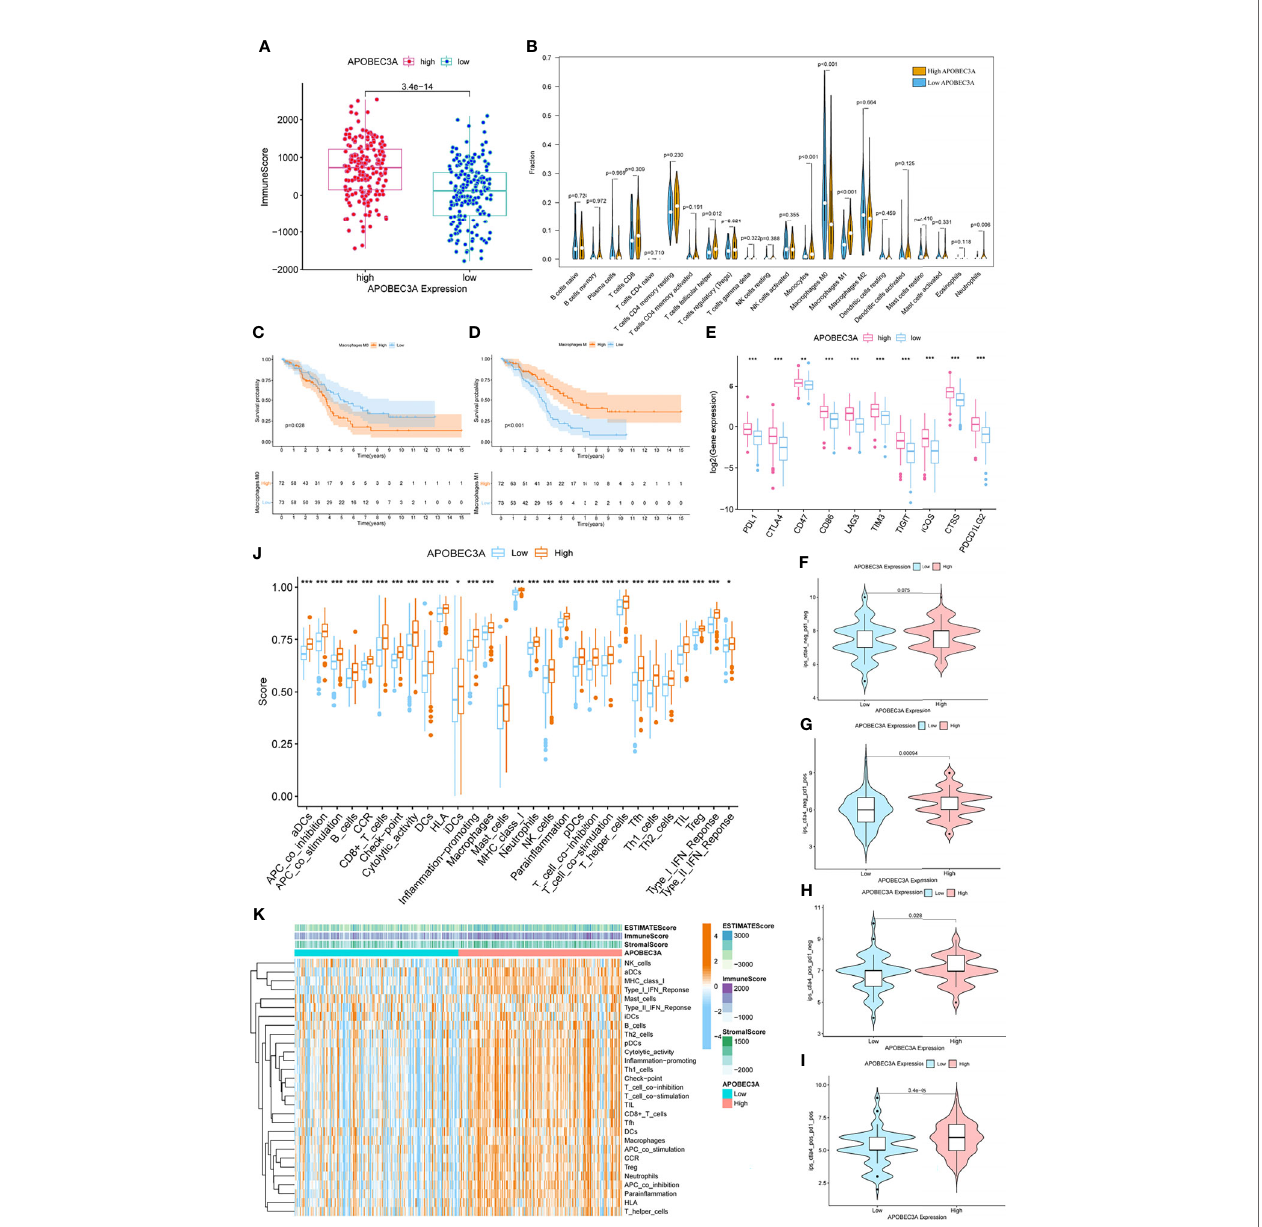
FIGURE 4 | Immunity analysis of APOBEC3A high- and low-expression cohorts in ovarian cancer (OC) patients. (A) The correlation of APOBEC3A with ImmuneScore, Wilcoxon rank sum was applied for the signi fi cance test. (B) Violin plot showed the ratio differentiation of 22 types of immune cells between OC tumor samples with high or low expression relative to the median of APOBEC3A expression, and Wilcoxon rank sum was applied for the signi fi cance test. (C, D) Kaplan – Meier curves show the independent relevance between overall survival time and Macrophage M0 and Macrophage M1. (E) The correlation between common inhibitory immune checkpoints (ICPs) and APOBEC3A high- and low-expression cohorts; Wilcoxon rank sum was applied for the signi fi cance test. The results showed that the expression of ICPs was all signi fi cantly positive-correlated with APOBEC3A group. *** p < 0.001. (F) The correlation of APOBEC3A with Immunophenoscores (IPS) in OC patients who have not received anti-CTLA4 or anti-PD-1 immunotherapy. (G) The correlation of APOBEC3A with IPS in OC patients who have only received anti-PD-1 immunotherapy. (H) The correlation of APOBEC3A with IPS in OC patients who have only received anti-CTLA4